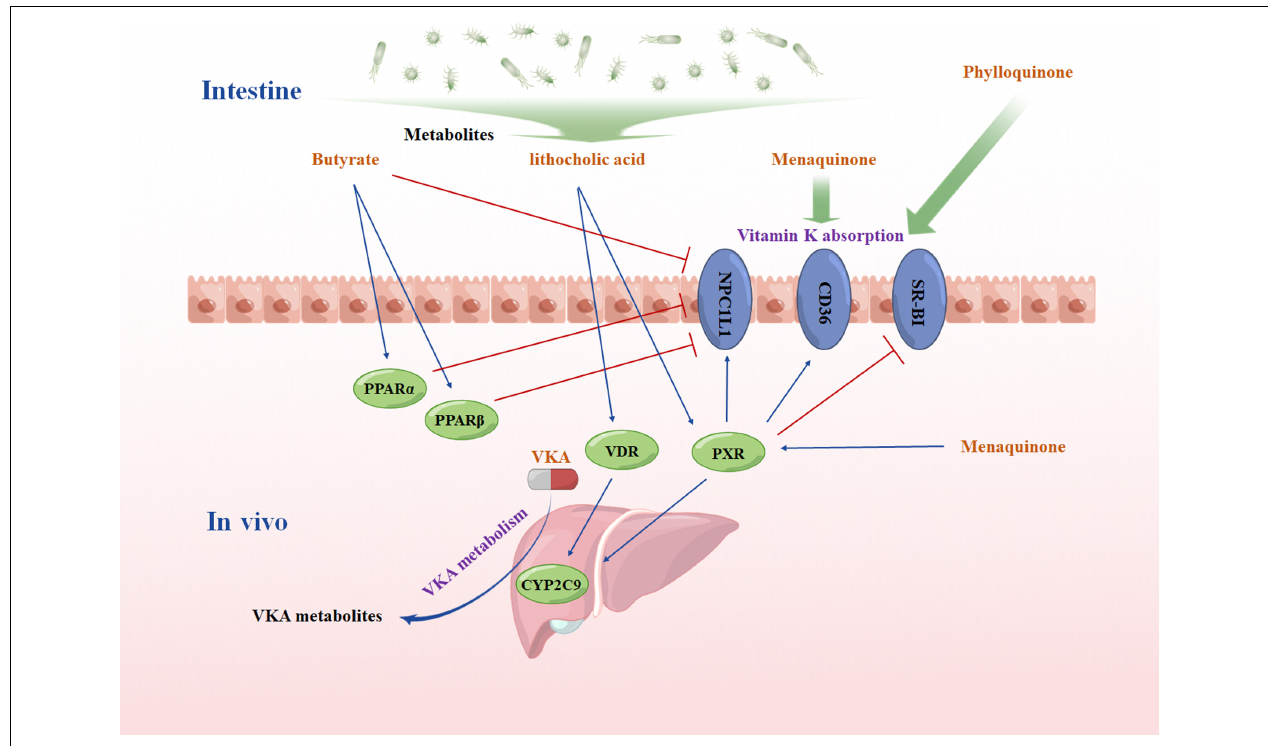
FIGURE 2 | A hypothesis diagram of intestinal microbiome affects the anticoagulant response of vitamin K antagonist VKA, vitamin K inhibitors; PPAR α , the peroxisome proliferator-activated receptor α ; PPAR β , the peroxisome proliferator-activated receptor β ; PXR, pregnane X receptor; VDR, vitamin D receptor; NPC1L1: NPC1like intracellular cholesterol transporter 1; SR-BI: scavenger receptor Class B Member 1; CYP2C9, cytochrome P450 Family 2 Subfamily C Member 9. The figure was drawing by Microsoft PowerPoint 2016, and the materials were provided by Figdraw (www.figdraw.com).